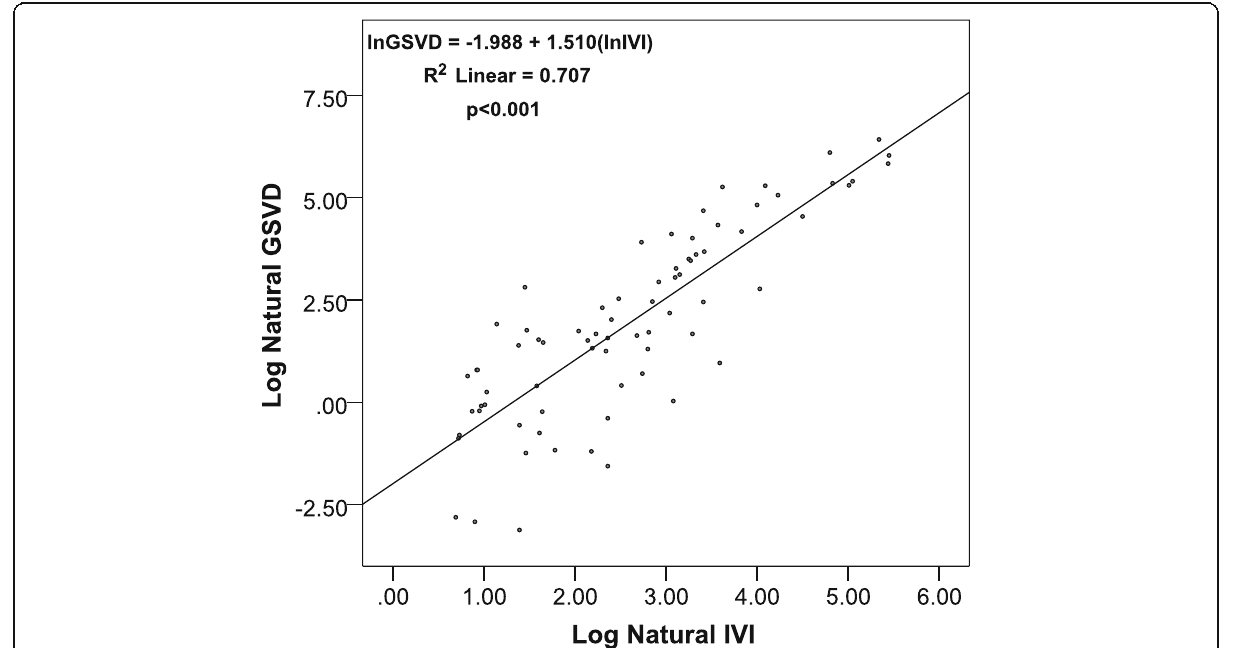
Fig. 4 Linear regression between Log e IVI and Log e GSVD of all the tree species under different forest